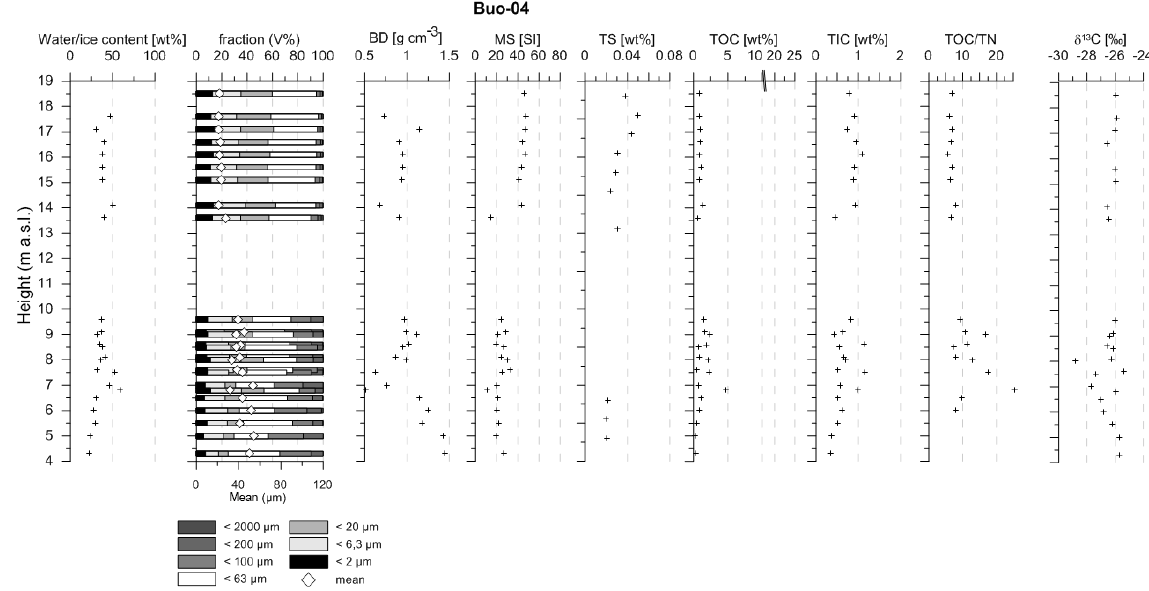
Figure 6. Soil and organic matter properties of the Buo-04 profile (note that due to overlapping sub-profiles, different values may be displayed at similar heights).